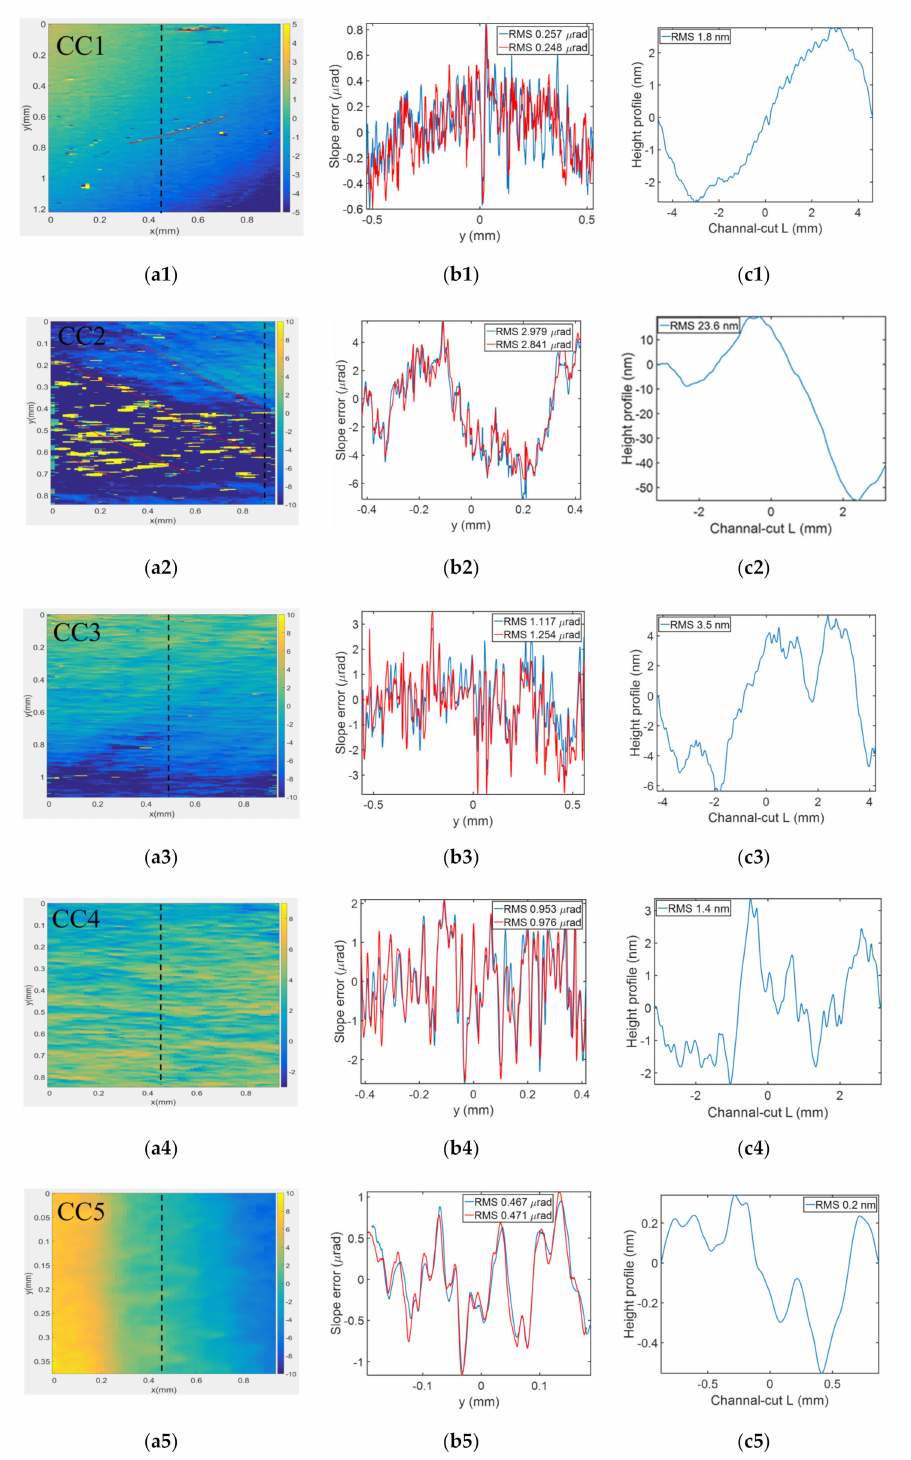
Figure 3. ( a1 – a5 ) The vertical wavefront slope errors, and ( b1 – b5 ) slope errors corresponding to the black dashed line. ( c1 – c5 ) The residual height profile of slope errors in the meridional direction for five channel